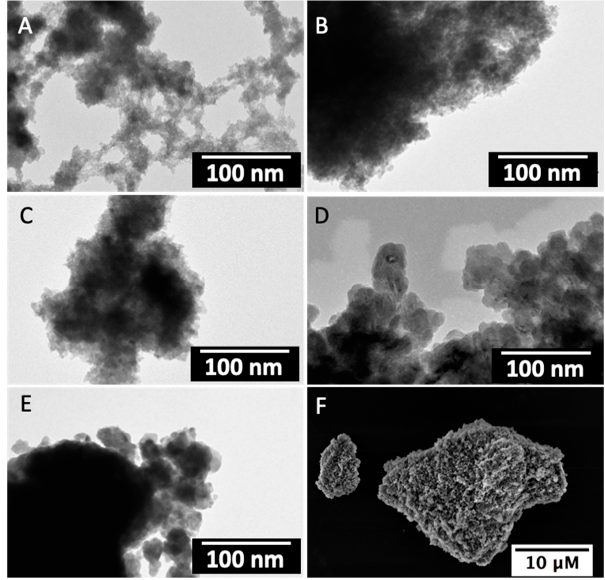
Figure 4. TEM micrographs of synthesized TiO 2 NPs before (( A ), TiO 2 _0 h) and after the thermal treatment at 110 ◦ C in an oven carried out for 2 h (( B ), TiO 2 _2 h), 8 h (( C ), TiO 2 _8 h), 16 h (( D ) TiO 2 _16 h) and 24 h (( E ), TiO 2 _24 h). SEM micrograph of TiO 2 NCs aggregates after 16 h of thermal treatment at 110 ◦ C in oven ( F